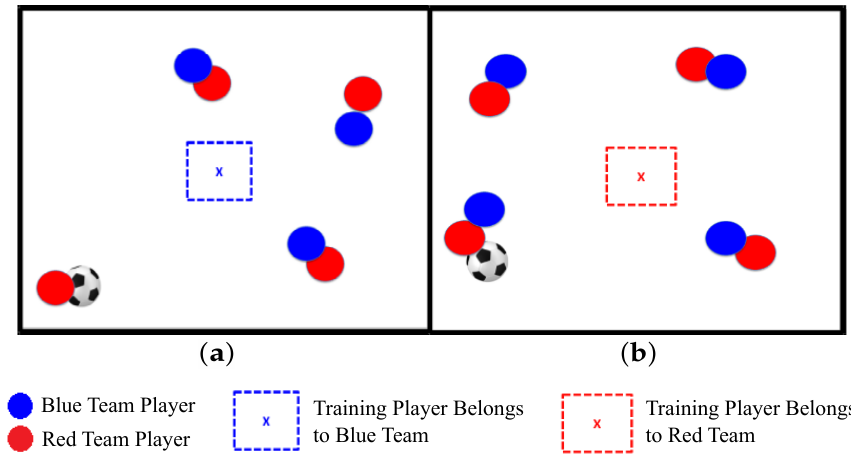
Figure 2. Visual stimuli examples of soccer marking and passing tactical situations. ( a ) Visual stimulus of defensive tactical situation. ( b ) Visual stimulus of offensive tactical situation [8].